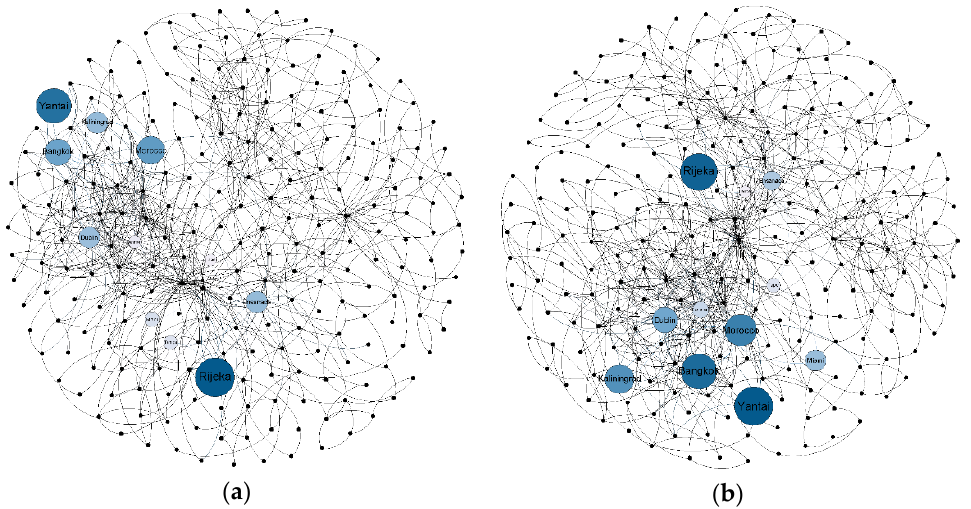
Figure 7. The global container shipping network comparison under service capability configuration: ( a ) before configuration ( b ) after configuration.